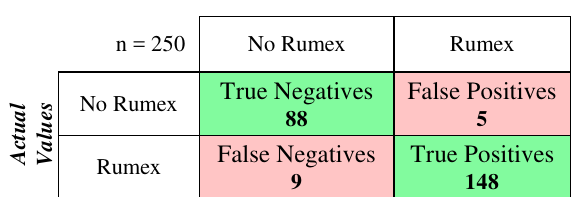
Figure 8. Confusion Matrix – Classification with 75% training data for basic dataset.